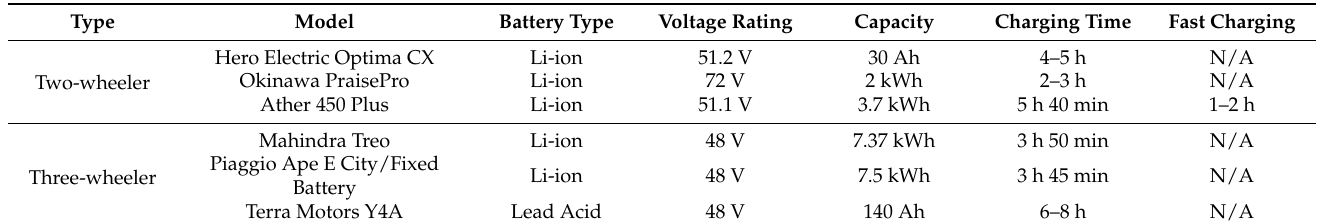
Table 1. Some commercially available LEVs and their battery/charging